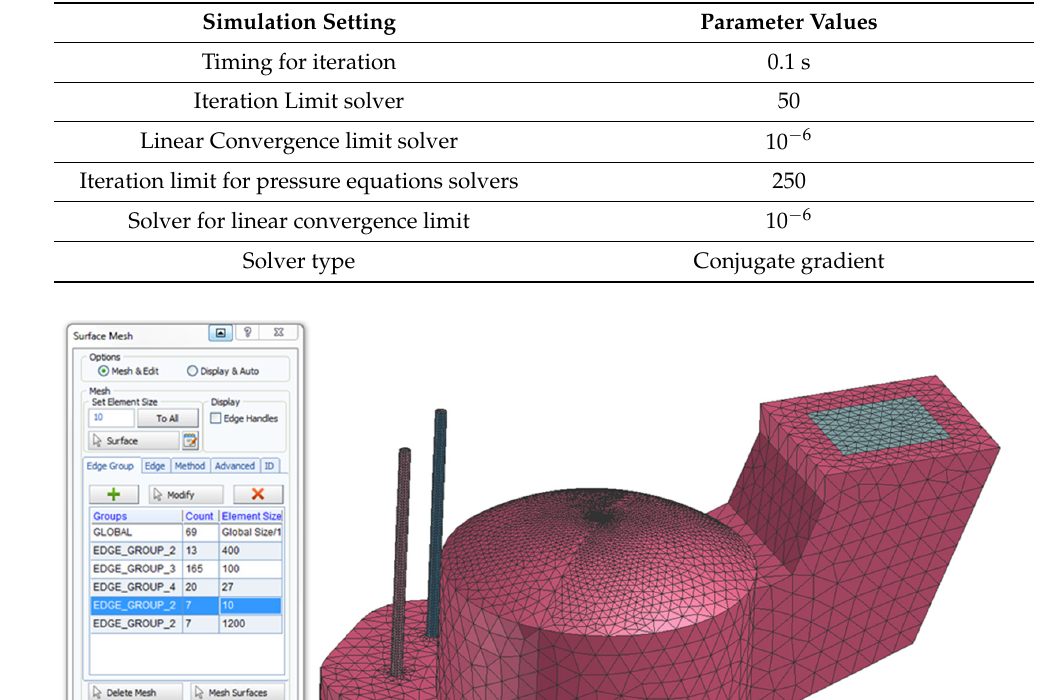
Table 1. Properties of castable materials considered in the numerical simulation.